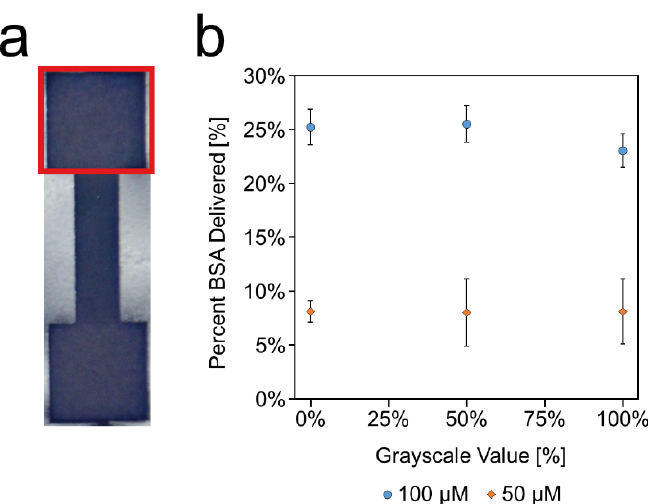
Figure 10. Protein transport. ( a ) Intensity of the red channel in the outlet (red square) was measured before deposition and 30 min after deposition to determine the red color shift. This value was then used to calculate the quantity of BSA-TR that made it to the outlet. ( b ) Percentage of deposited BSA- TR that wicked to the outlet of a 10 mm long, 3 mm wide channel etched at different grayscale values. Data presented as mean ± SD. n =